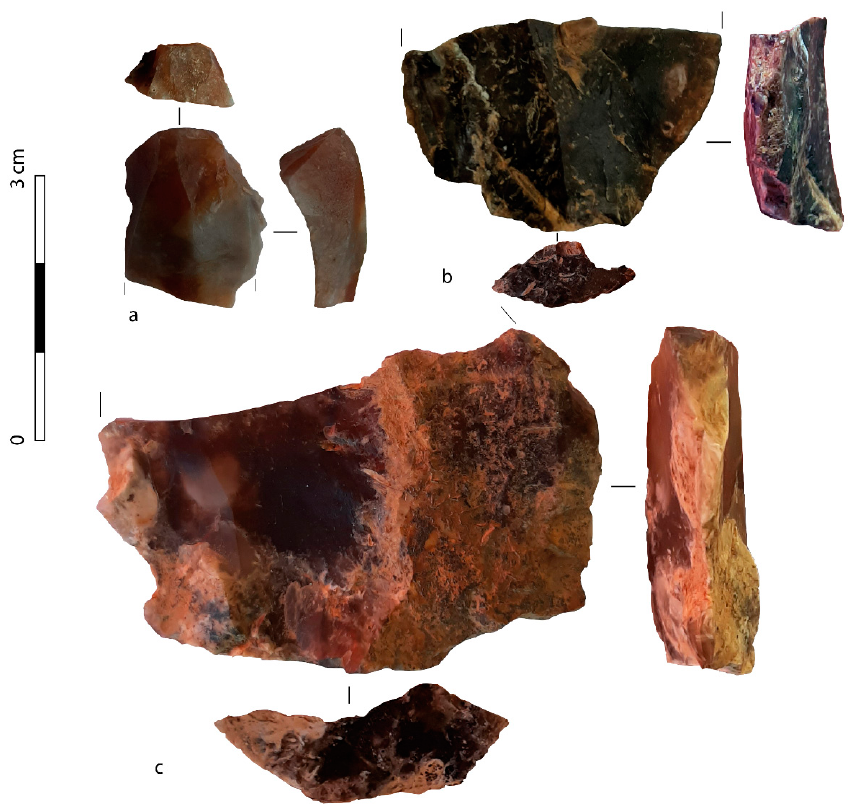
Figure 10. Lojanik 3, lithic artefacts: ( a ) bladelet core from LFS1; ( b , c ) fragmented large laminar blanks from LFS2.